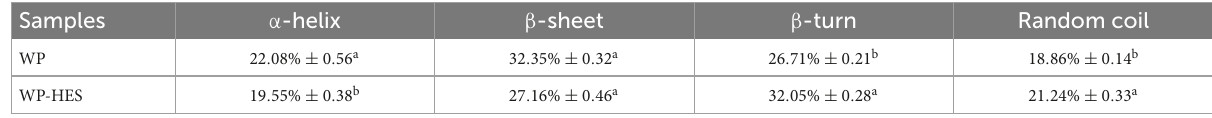
TABLE 3 Secondary structure contents in WP and